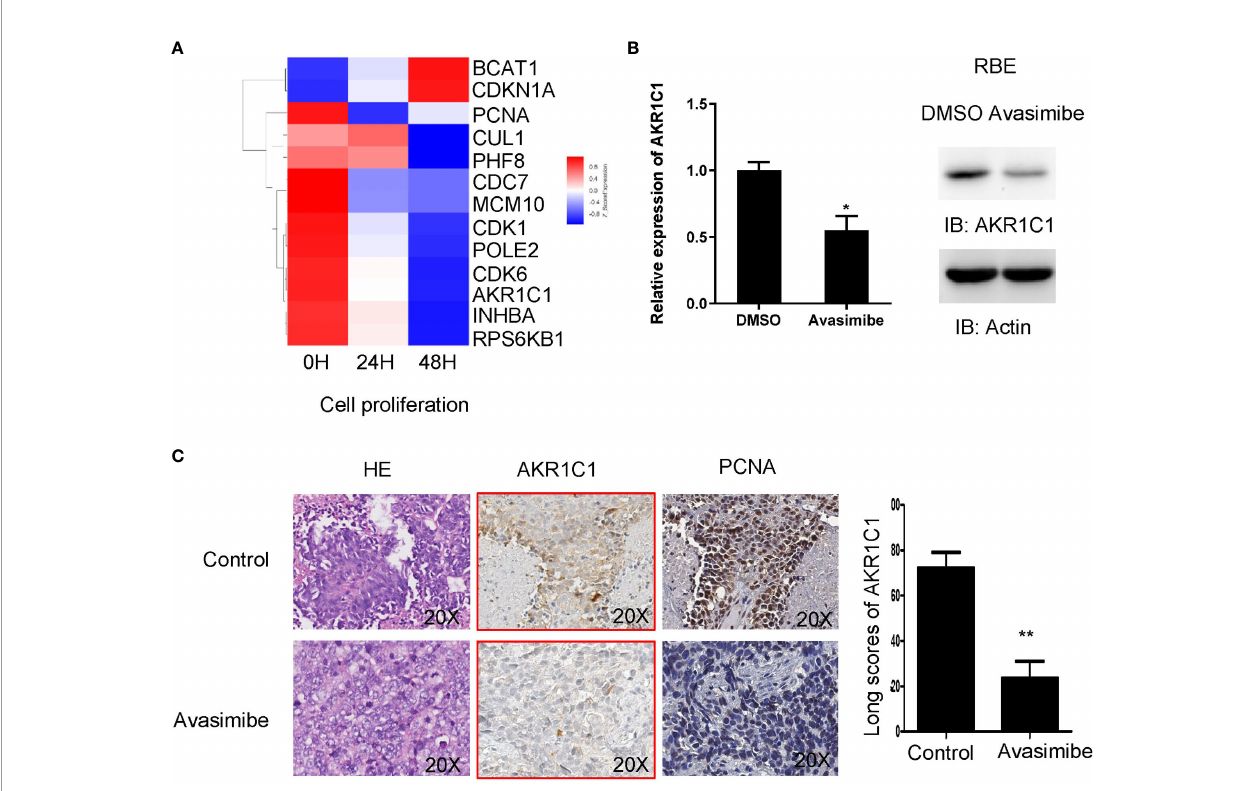
FIGURE 2 | cDNA array analysis identi fi ed AKR1C1 as a potential target of avasimibe. (A) RBE cells were treated with avasimibe at the concentration of 20 µM for 24 and 48 hours and subjected to cDNA array analysis. Cluster of changed genes in cell proliferation was presented. (B) The level of AKR1C1 mRNA and protein was detected by RT-PCR and western blotting in RBE cells when treated with avasimibe (20µM) for 48 hours. (C) The expression of AKR1C1 and PCNA was detected by IHC on the resected xenografts. IHC, ×200. *P < 0.05, **P < 0.01. ‘ long scores of AKR1C1 ’ means AKR1C1 staining score. IHC,